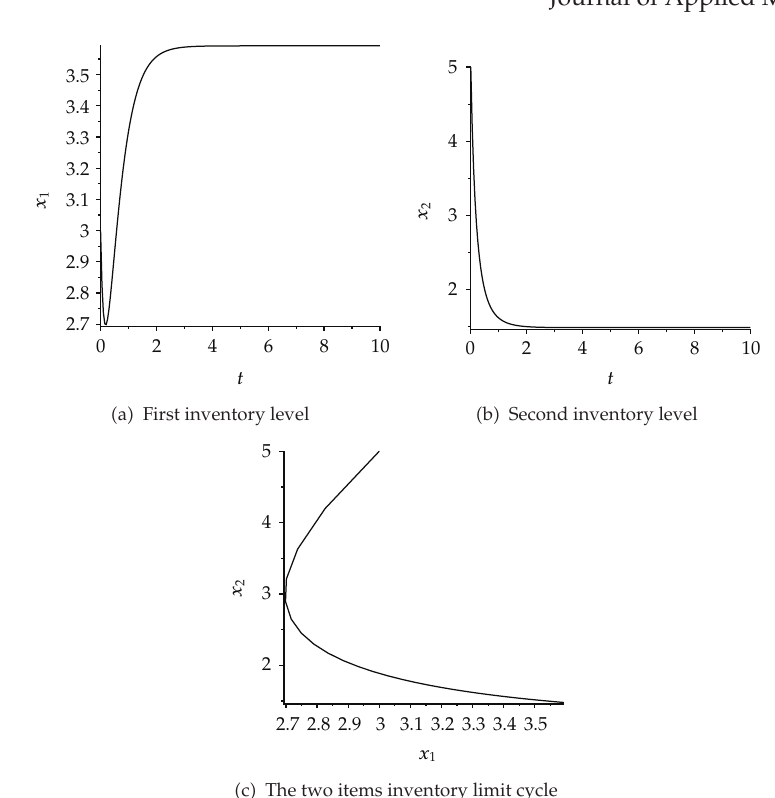
Figure 2: (cid:6) a (cid:7) and (cid:6) b (cid:7) are the first and the second inventory levels of the uncontrolled system, with constant rates of supply. (cid:6) c (cid:7) is the trajectory of the inventory system in x 1 x 2